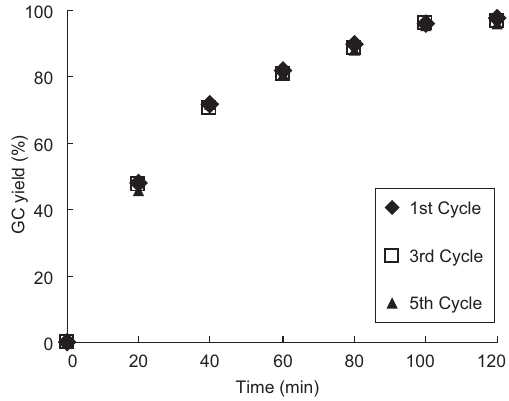
Figure 1 Removal of catalyst by hot fi ltration at 20 min versus a standard reaction of iodobenzene and phenylacetylene.